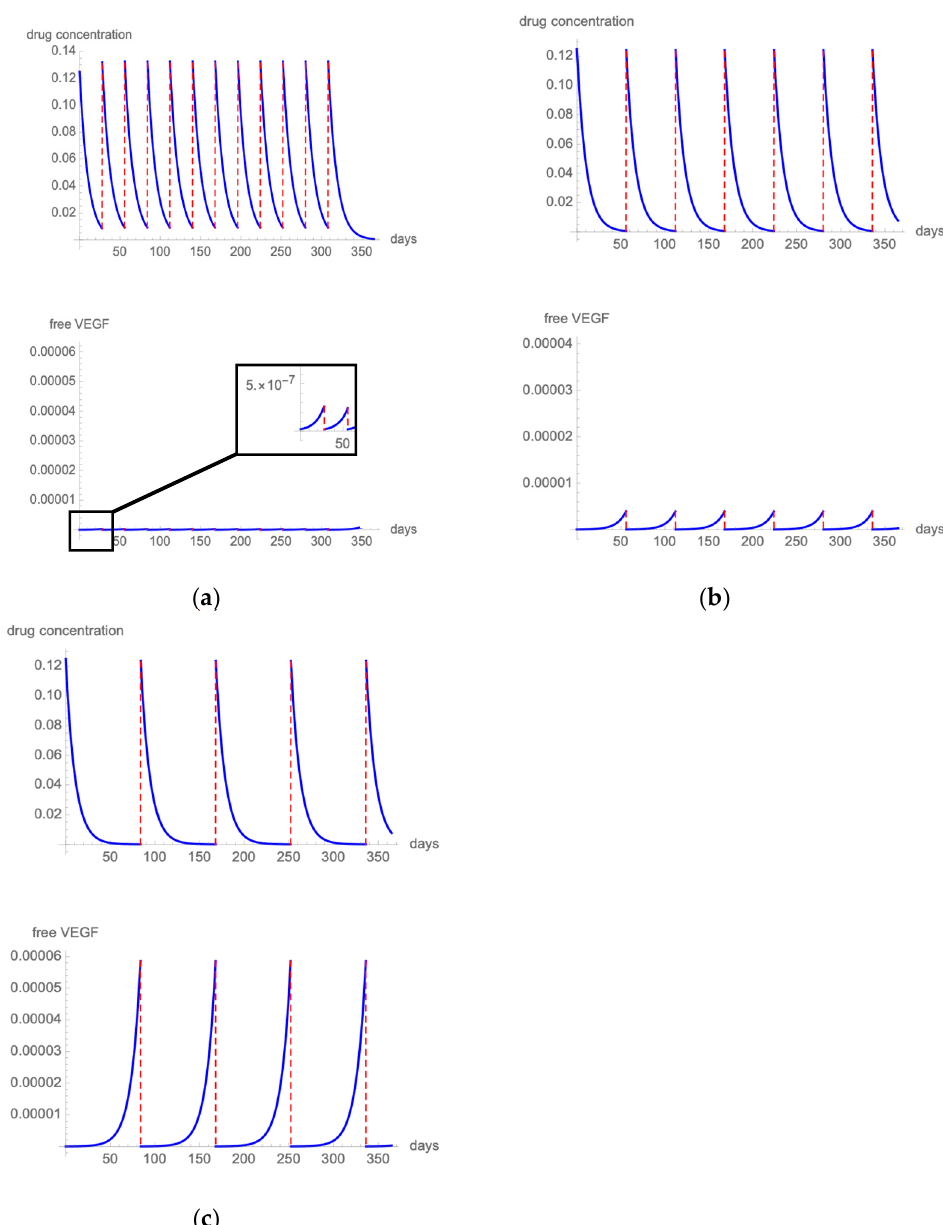
Figure 2. Figure 2 illustrates the intravitreal drug concentration and free VEGF proportion in a patient treated with q4 ( a ), q8 ( b ), or q12 ( c ) 0.5 mg ranibizumab injections.